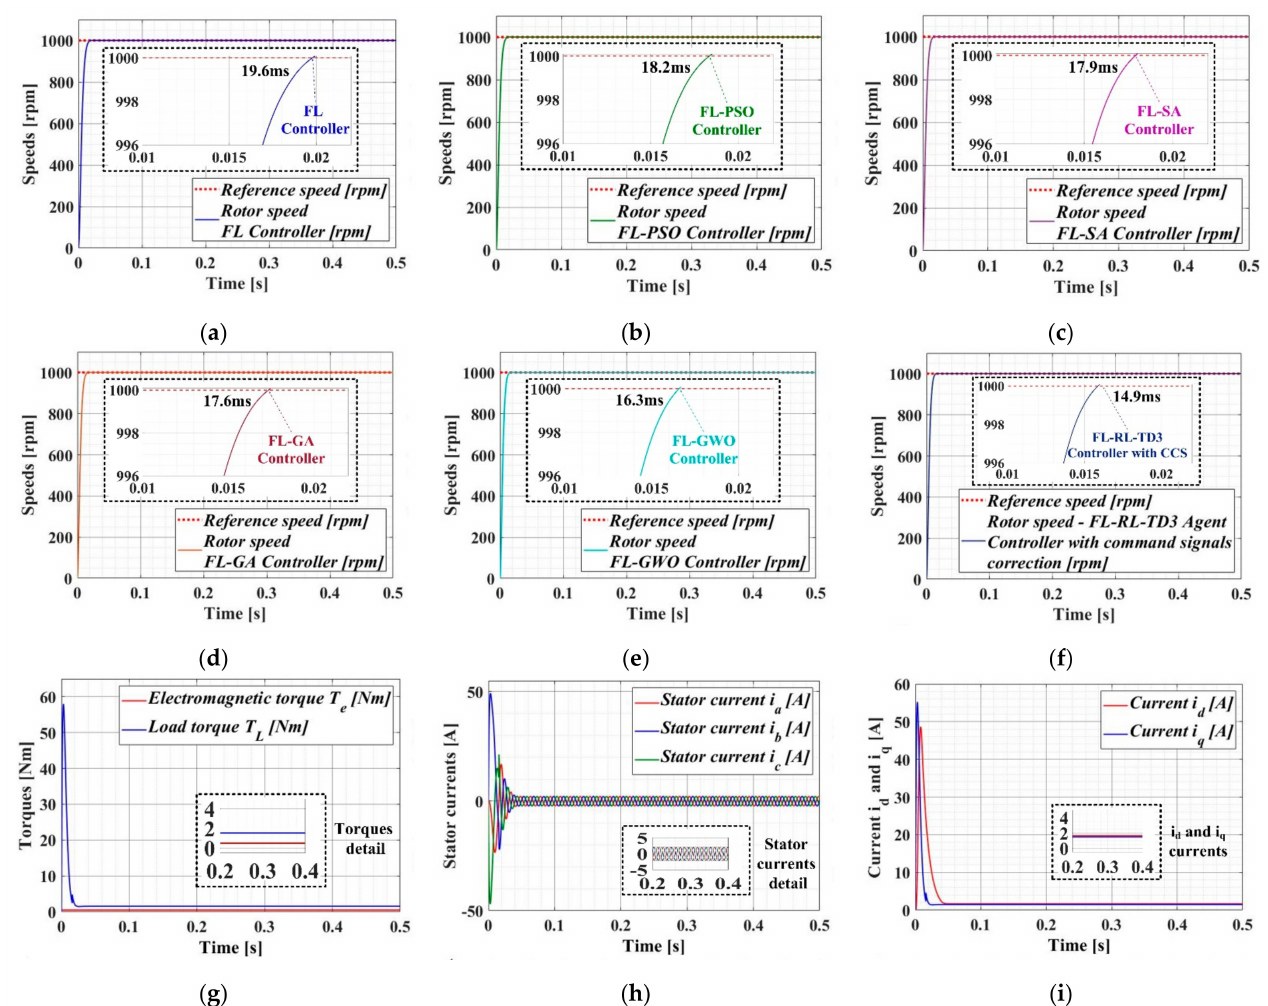
Figure 15. Time evolution of the parameters of the PMSM–CS–CI based on the FL-type controller: